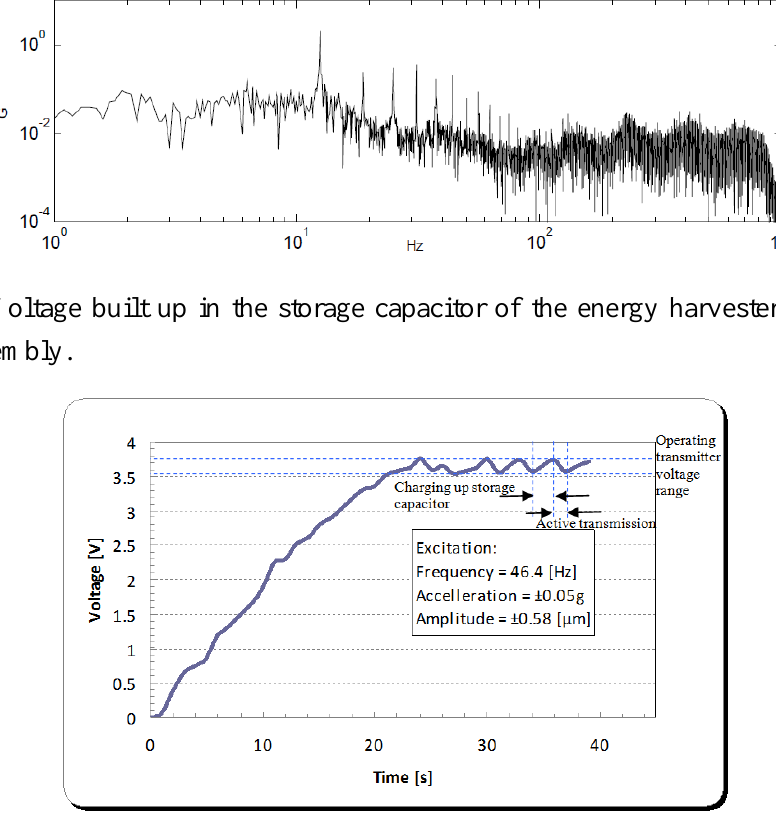
Figure 28. Power balance of the energy harvester and read-out circuitry